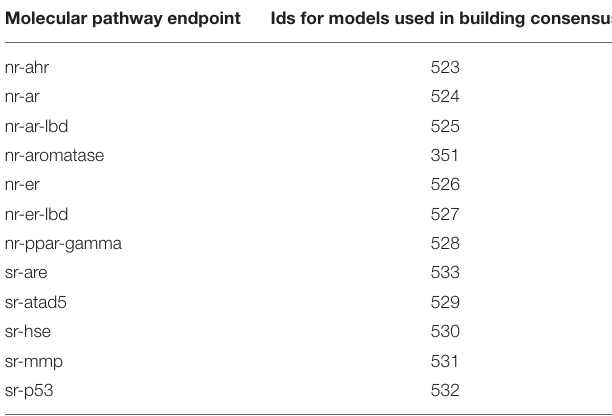
TABLE 5 | Performance of the consensus models involving all 10 descriptor packages for each pathway endpoint. Molecular